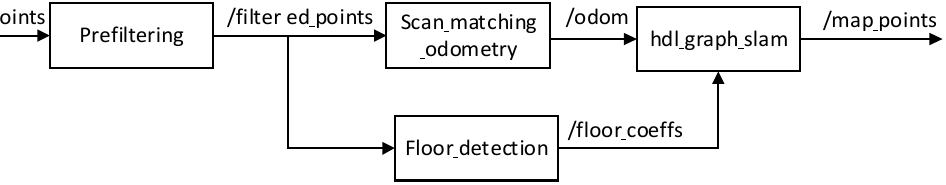
Figure 4. Overview of the nodes of the hdl_graph_slam [34]. Prefiltering